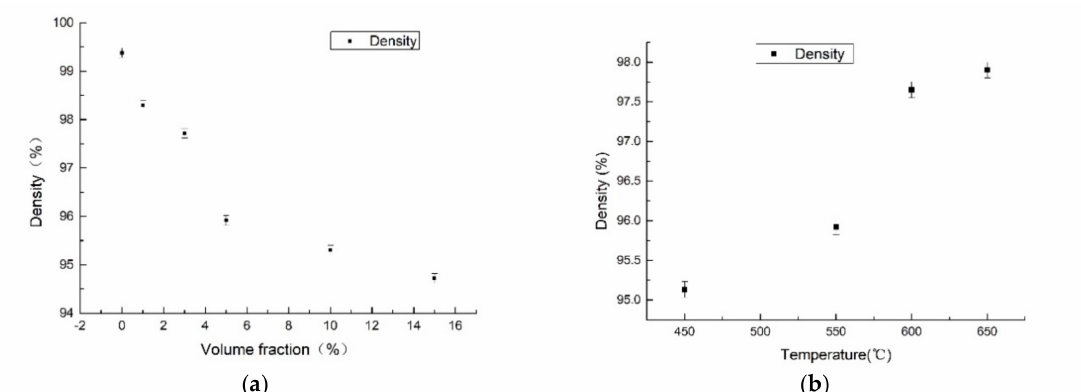
Figure 11. The curve of the relative density of AA6061 / N-SiCp composite: Relationship between relative density and volume fraction for AA6061 / 5 vol.% N-SiCp sample ( a ). Relationship between relative density and sintering temperature at 4.5 GPa for AA6061 / 5 vol.% N-SiCp sample ( b